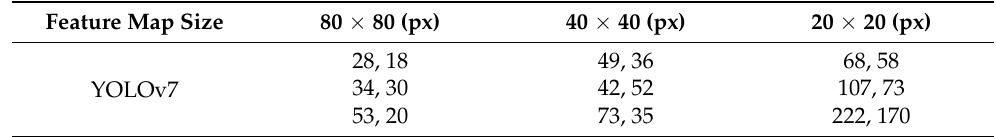
Table 5. Anchor box parameters of the Brackish